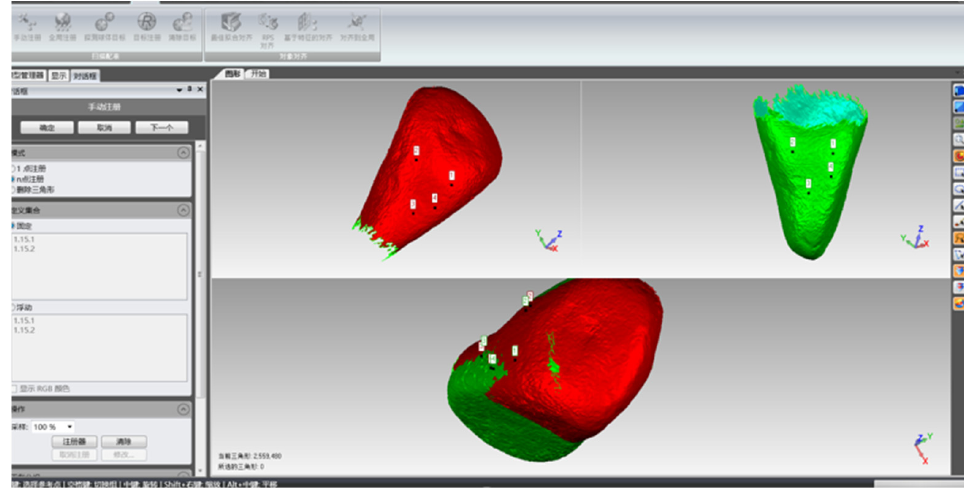
Figure 11. Coarse aggregate models splicing process.